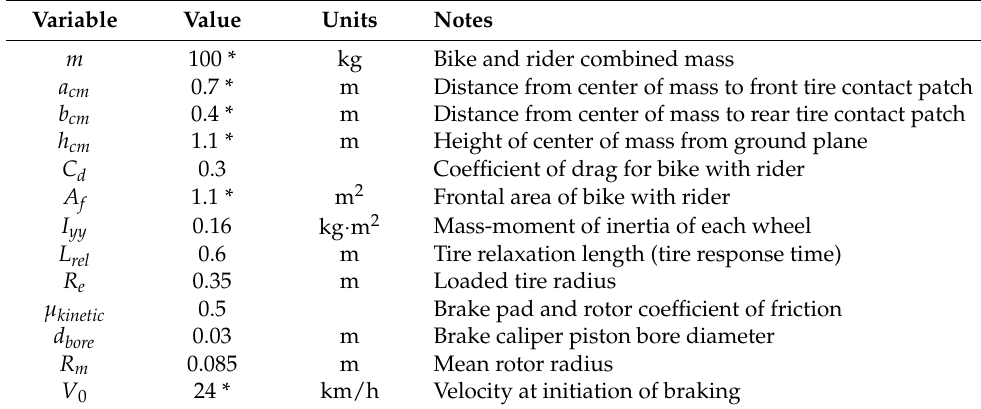
Table 2. Values selected for each variable used in the bicycle longitudinal dynamics and bicycle tire simulation blocks during corroboration tests.